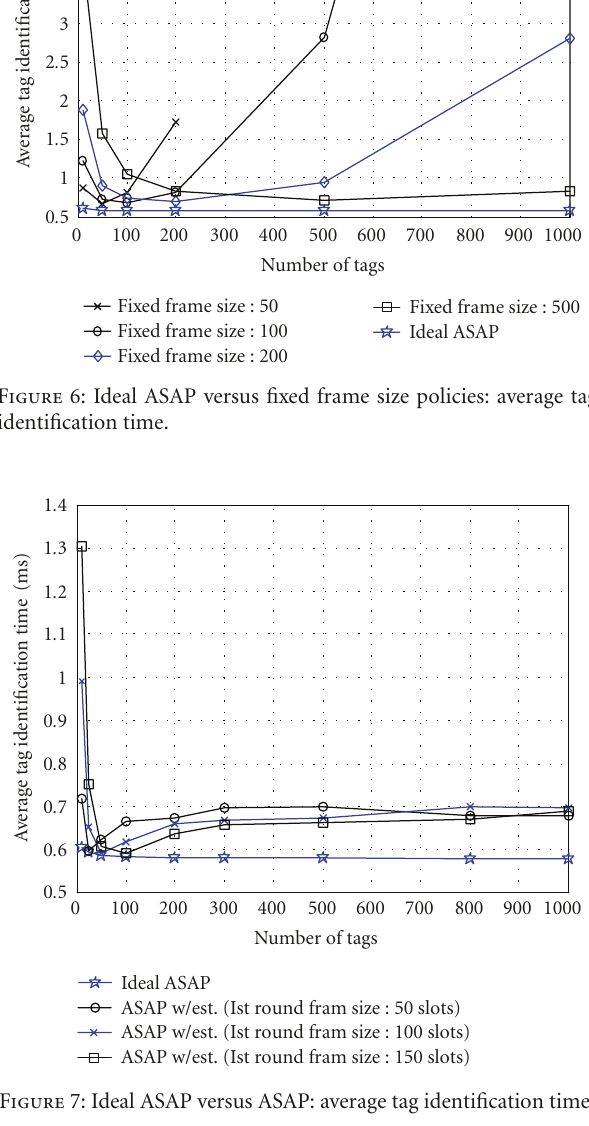
Figure 7: Ideal ASAP versus ASAP: average tag identification time.